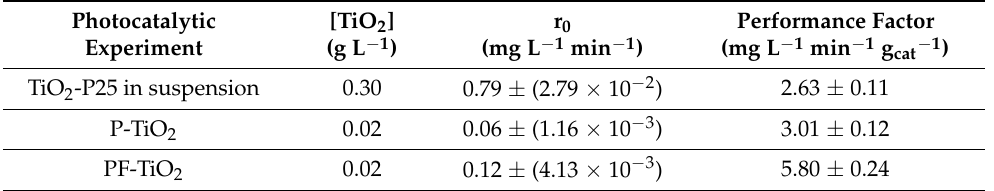
Table 1. Comparison of the photocatalytic performance of TiO 2 -based catalysts: suspended, P: sub- merged photocatalytic membrane, PF: photocatalytic membrane and flow-through permeation exper- iments for DCA